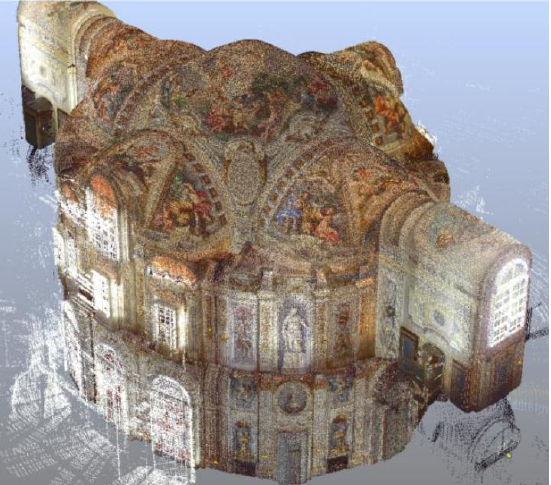
Figure 3 TLS point clouds adjusted in the same coordinate system